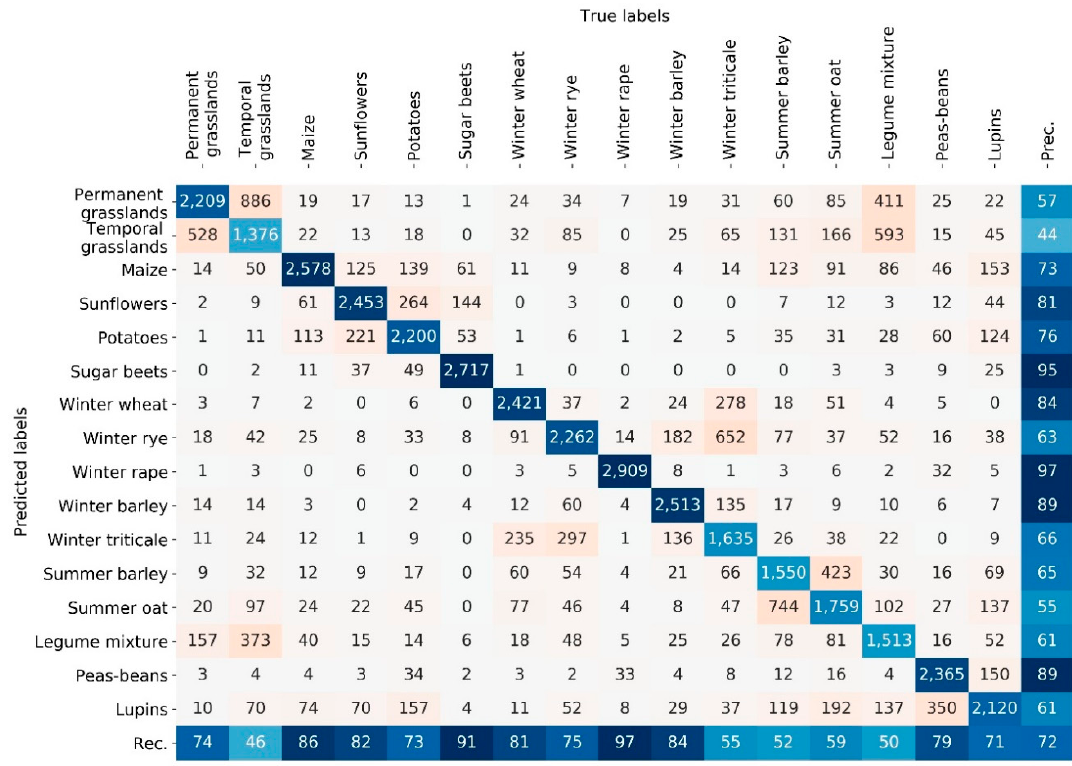
Figure 9. Confusion matrix derived from the classification results using a combination of optical and SAR features ( ff(S1&S2)) .